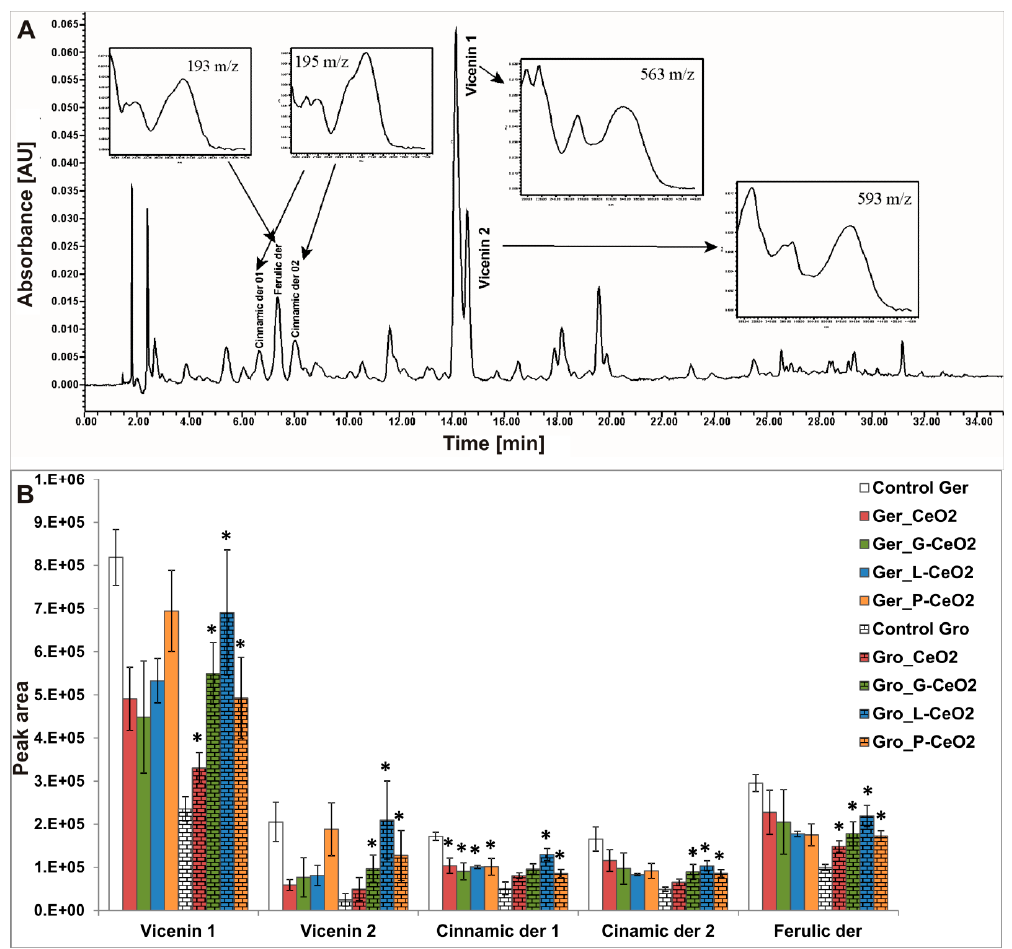
Figure 7. (A ) High-performance liquid chromatography (HPLC) of the methanolic extracts of wheat shoots with ultraviolet–visible spectrometry (UV–Vis) of the dominant phenolic compounds; ( B ) Phenolic profile in wheat shoots after Ger and Gro treatment with different nCeO 2 . Values are shown as mean ± SE; * indicates statistically significant differences in comparison with the corresponding control, p < 0.05.